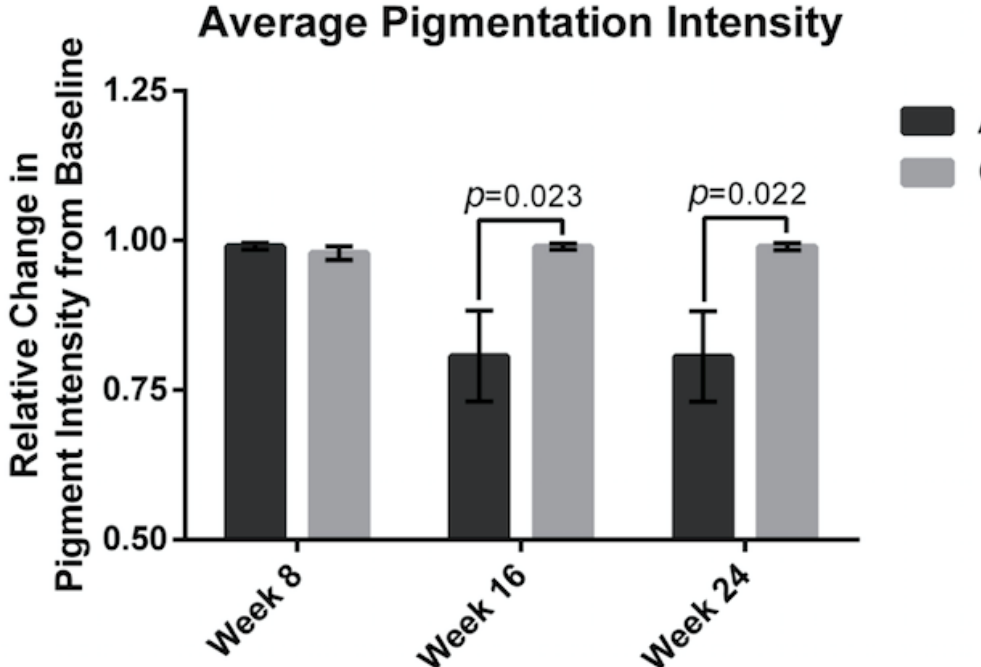
Figure 4. Relative change in skin pigment intensity was measured showing a 20% reduction from baseline in the almond group at both week 16 and 24. Significant p values are noted on the figure. Error bars represent SEM.